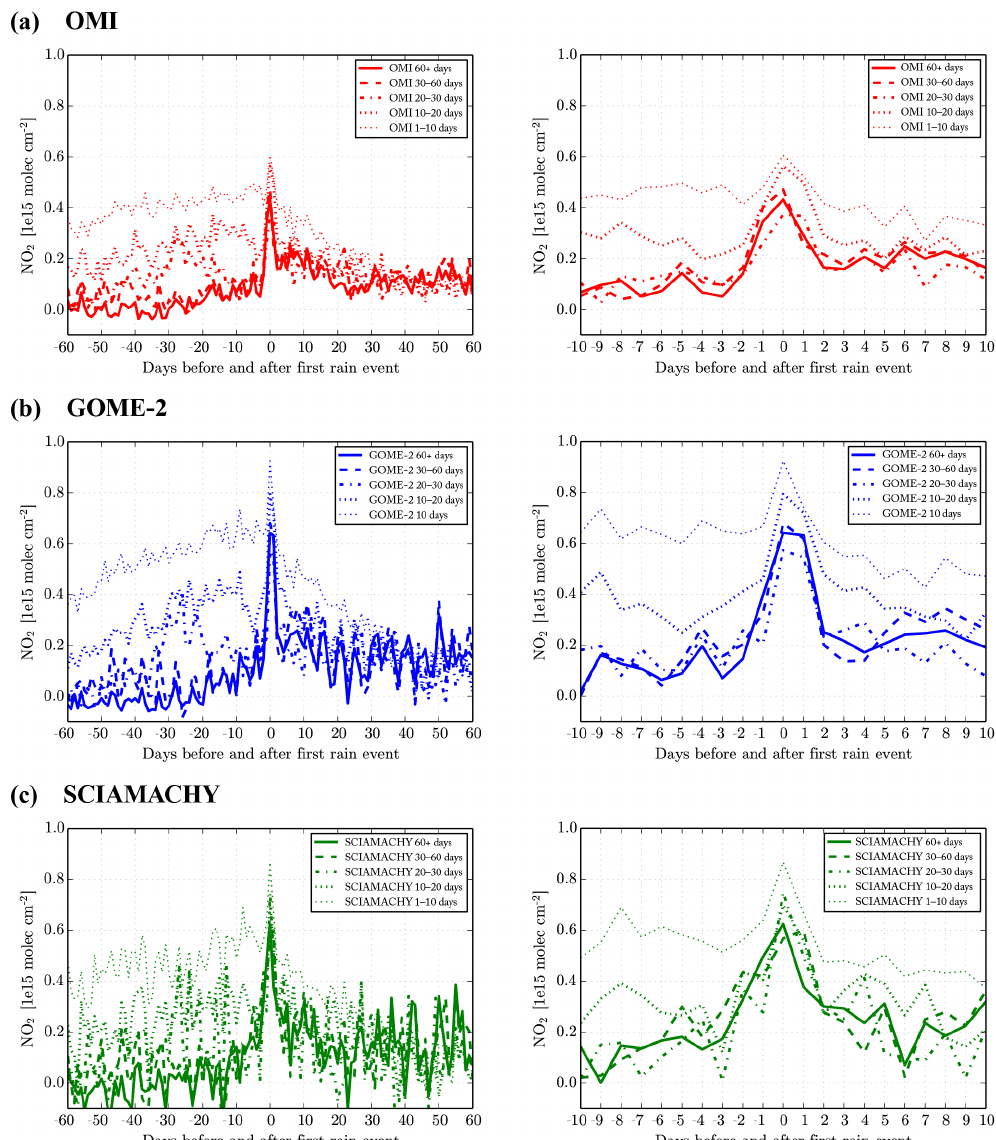
Figure B1. In this figure, NO 2 VCDs are shown from OMI (a) , GOME-2 (b) , SCIAMACHY (c) around the first day of rainfall for different preceding drought periods for the Sahel region with a precipitation threshold of 2mm. For better intercomparison, the latitudinal background correction with buffer as described in Sect. 4.5 is applied to each time series individually. The left panels represent the full time series of 60 days before and after Day0, the right panels show a zoom-in for the 10 days before and